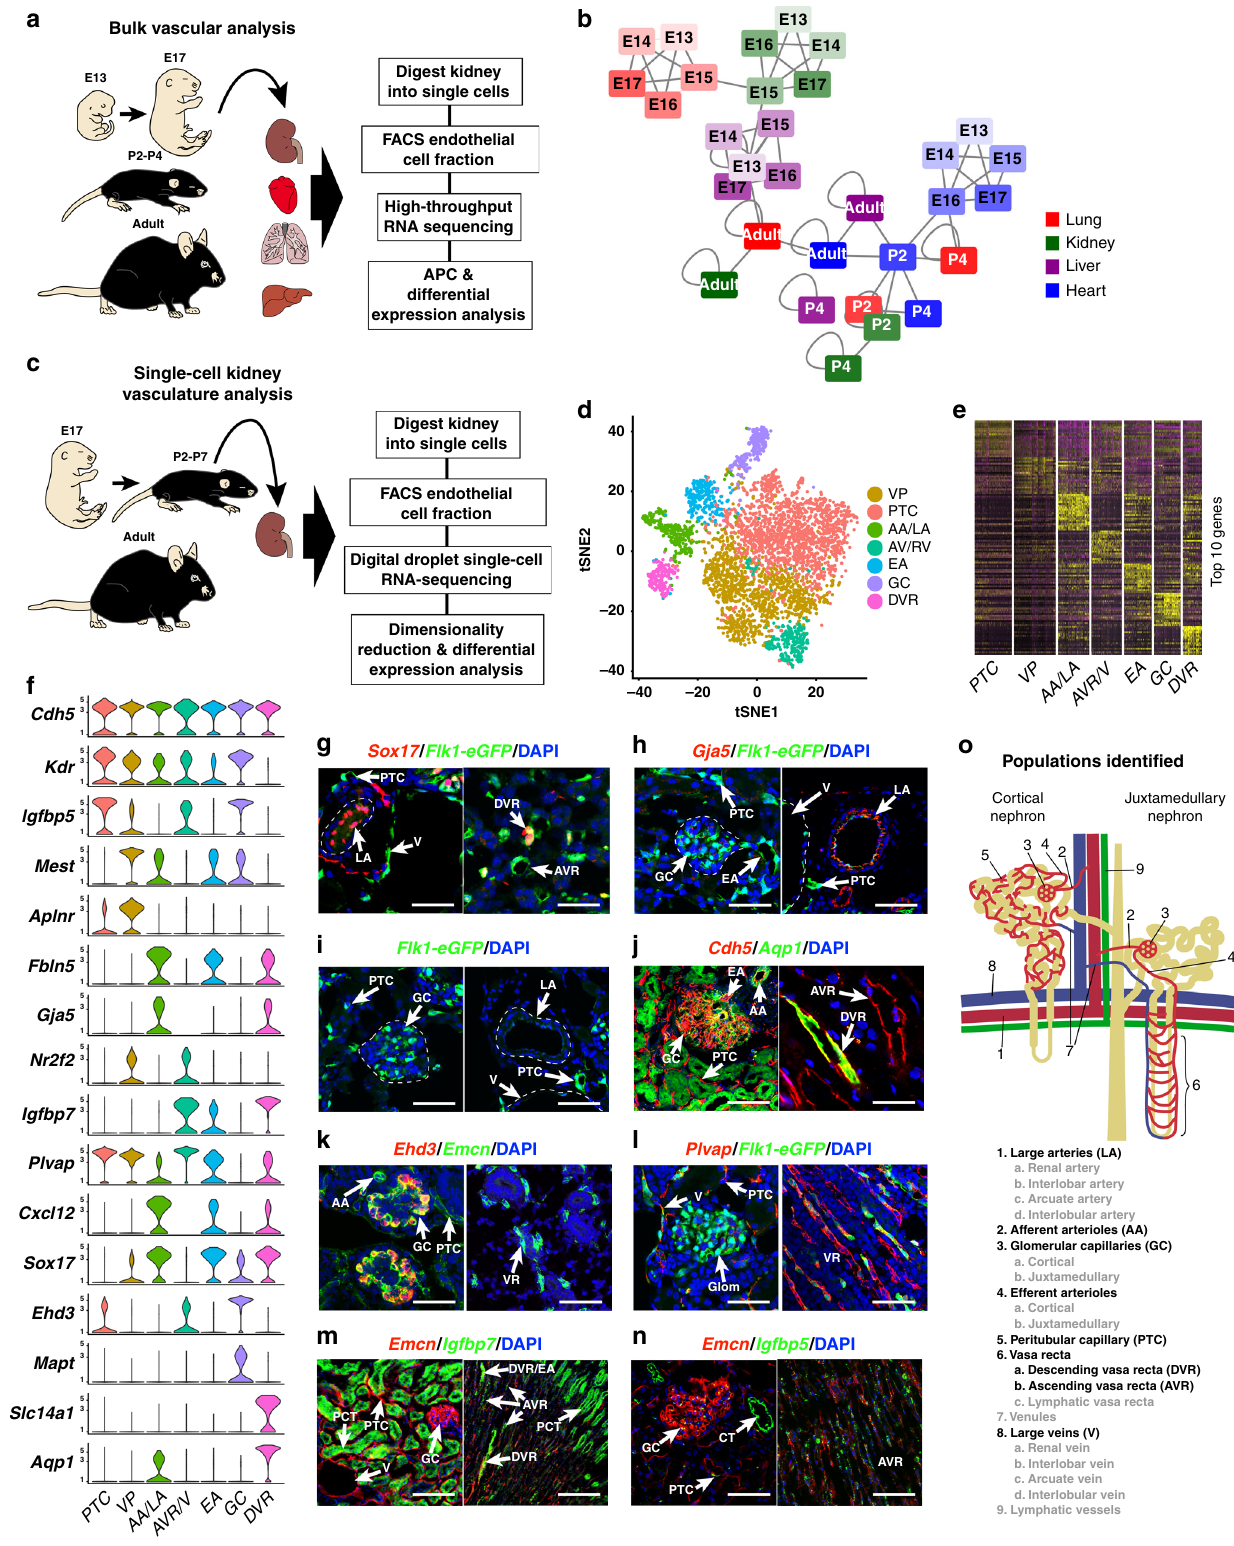
EC subsets in kidney execute de fi ned vascular functions . For each population, we selected one or two of the speci fi c genes amongst the top differentially expressed genes and validated the presence of protein expression in various EC populations. Most